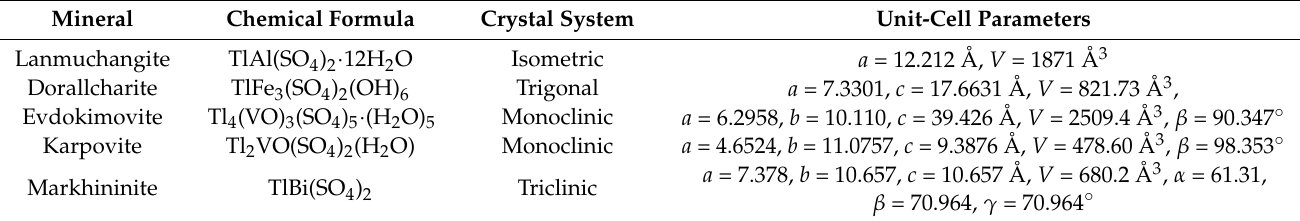
Table 2. Crystal chemistry for thallium sulfate minerals [68,76,82,101,114].